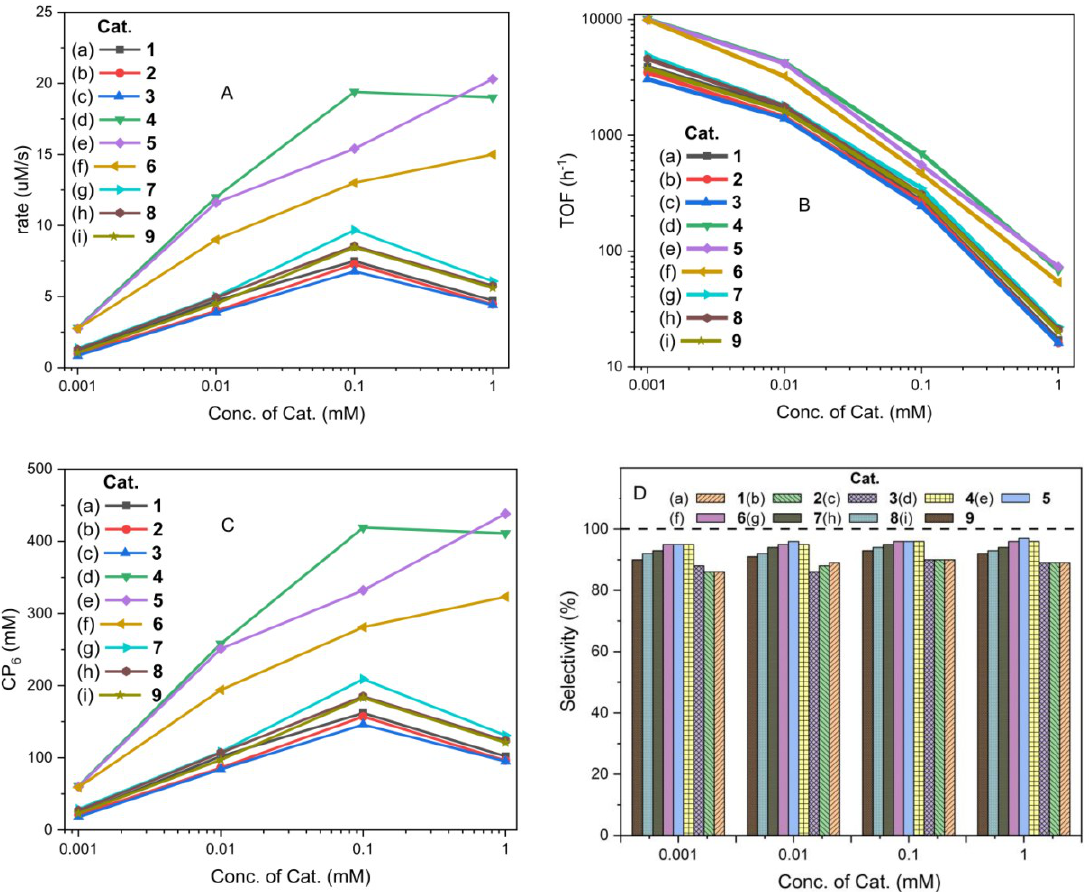
Figure 9. Catalytic oxidation of toluene, complexes 1 – 9 were loaded to the reaction system in various concentrations between 1.0 × 10 1 and 1.0 × 10 −3 mM. ( A ) The catalytic rate of complexes for the catalytic oxidation of toluene (μM s − ); ( B ) the catalytic frequencies; ( C ) the concentration of the product after 6 h of reaction time (mM); and ( D ) the chemoselectivity to